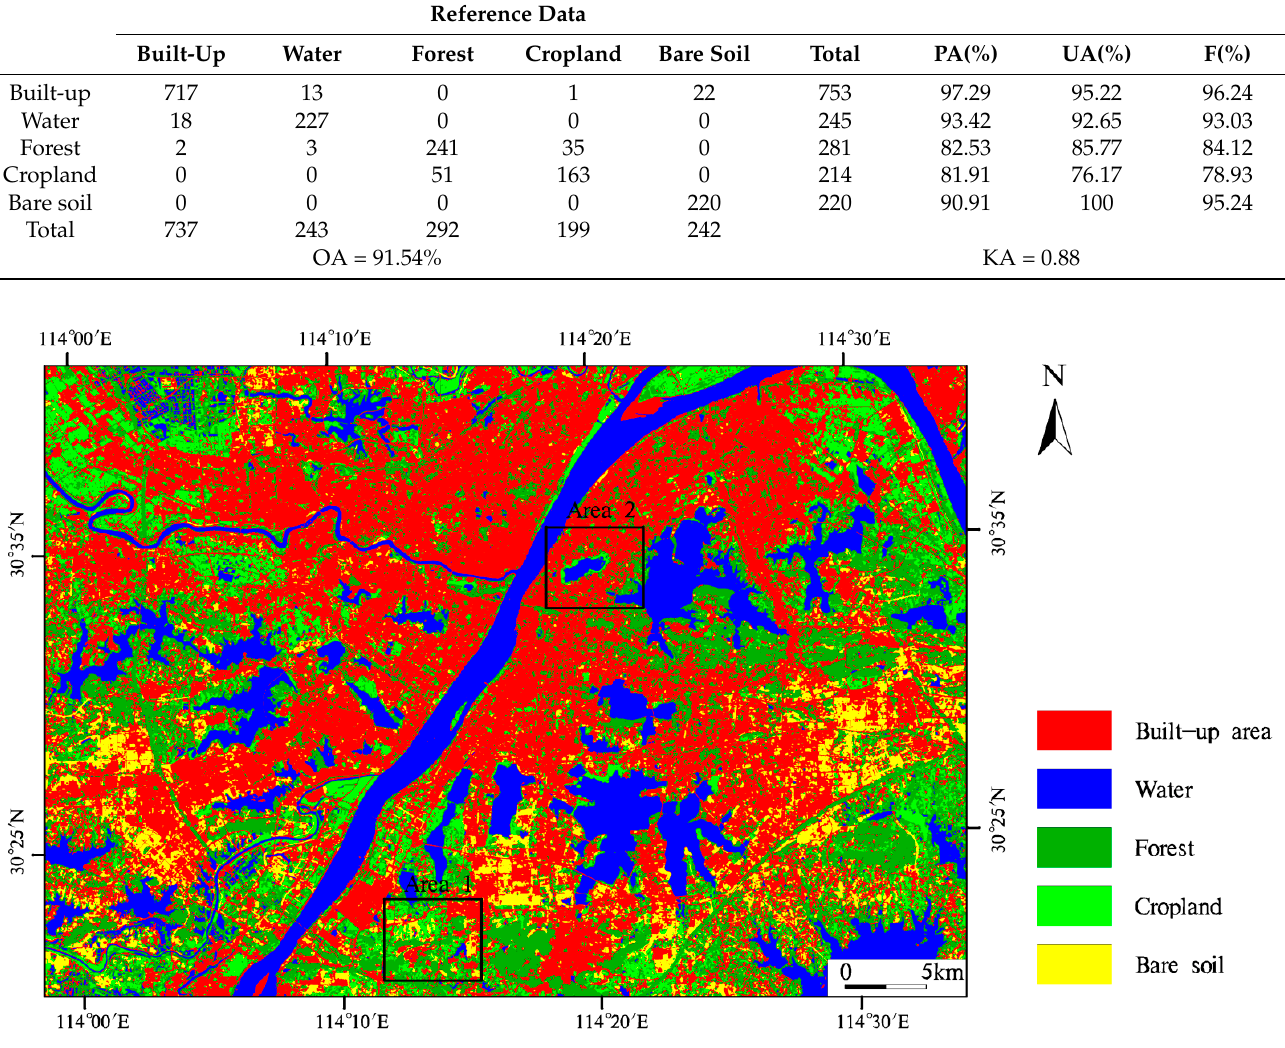
Figure 4. Land cover map obtained from the SVM-CK algorithm with the Sentinel-2B MSI image.